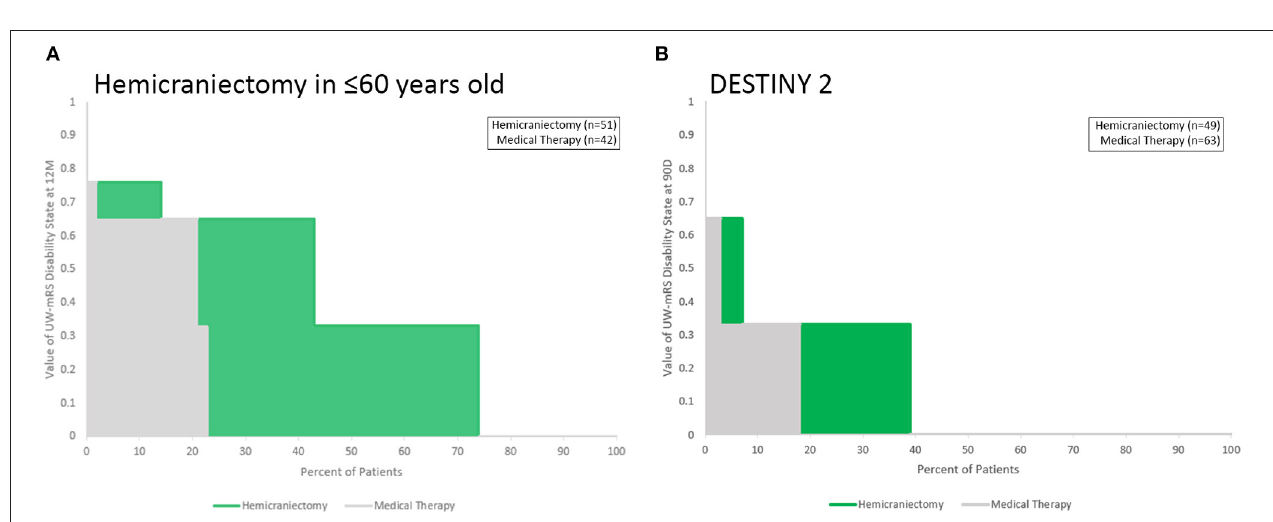
FIGURE 4 | Utility Staircase charts showing trials data for hemicraniectomy for malignant acute ischemic stroke. (A) Among patients up to age 60 years old; (B) among patients over 60 years old. The greater utility benefit among younger patients is readily apparent, as is the overall poor health-related quality of life outcomes in both control and treated groups in both age ranges (both gray and green color fields hew toward the lower left portion of the rectangular achieved utility